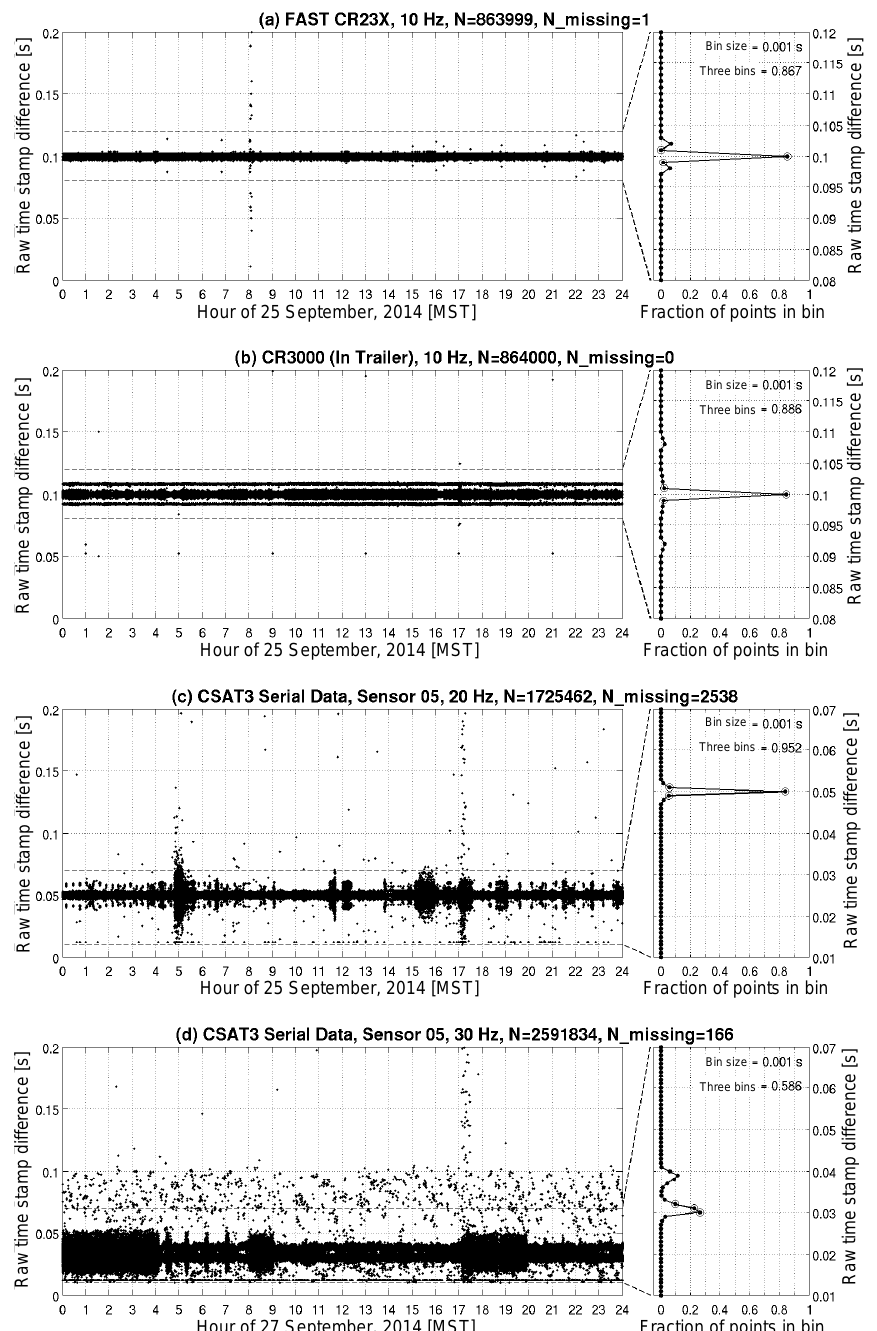
Figure 10. Time series of the time difference between high-rate data samples collected for different data systems at the US-NR1 site for (a) 10Hz data from the FAST CR23X logger using the ASTER/NDAQ configuration, (b) 10Hz data from a CR3000 connected to the Titan PC/104 running NIDAS in the trailer (prior to deployment at the tower), (c) 20Hz data from a CSAT3 collected by a Viper PC/104 computer running NIDAS, and (d) 30Hz CSAT3 data collected with the same Viper. Details are also listed immediately above each panel. The Viper PC/104 data system was added to the US-NR1 tower in September 2014 to collect data from seven CSAT3 sonic anemometers for a full year. To the right of the time series is a frequency distribution showing the number of samples within each time-difference bin. The dashed lines show the time-difference range used for the frequency distribution plot. The text in the right corner of each frequency distribution panel is the bin size used and the fraction of samples that the middle three values (highlighted by the open circle) make up of the